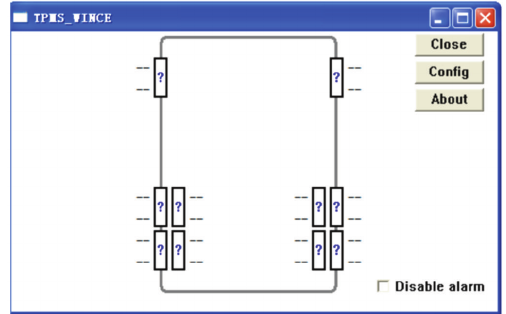
Figure 6: Software interface of TPMS